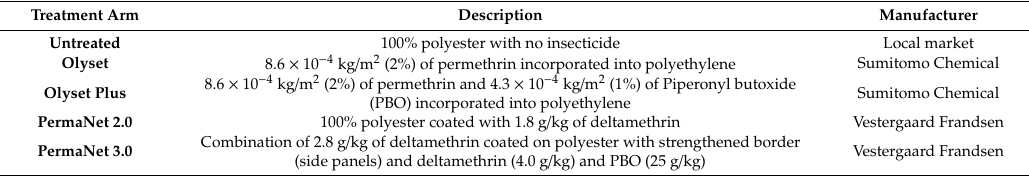
Table 1. Description of the long-lasting insecticidal nets